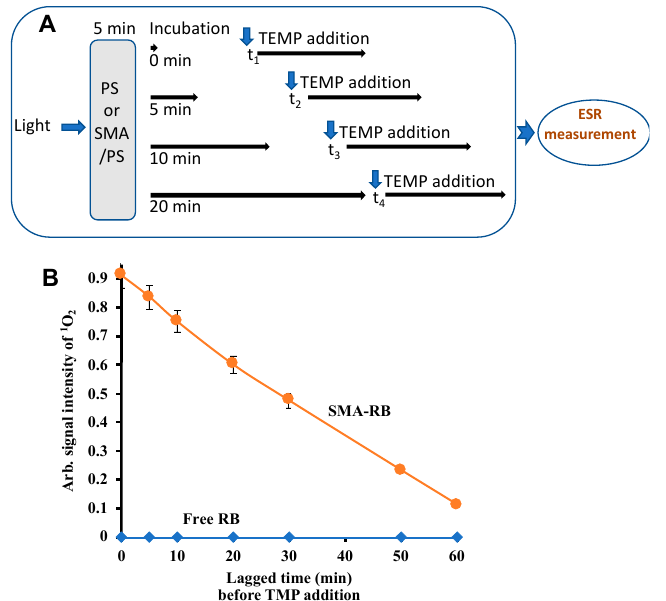
Figure 8. TMP/ 1 O 2 signal intensities against lagged time of incubation after light irradiation. ( A ) shows the diagrammatic representation of experimental condition of measuring ESR signals for SMA-PS micelles. The results of signal intensity of spin trapped 1 O 2 of cSMA-RB vs. free RB are shown in ( B ). Data are mean ± SD ( n = 3). See text for details.